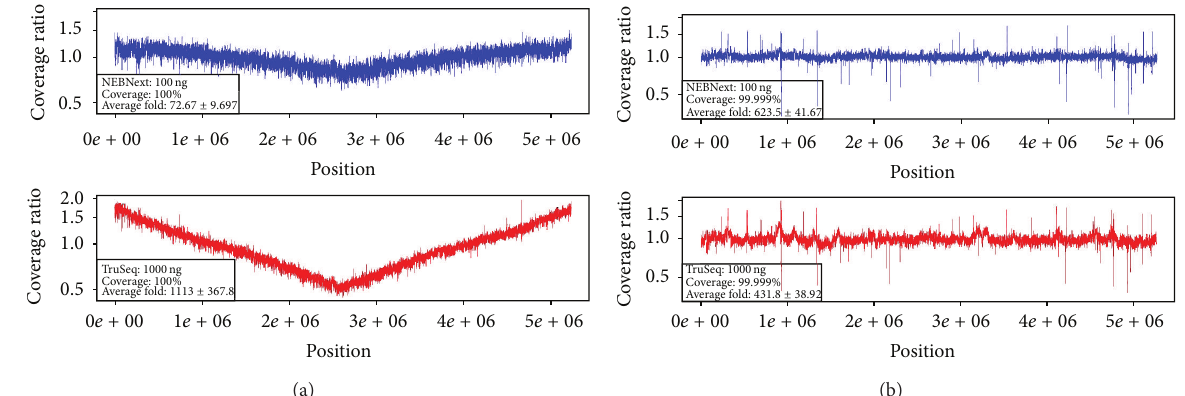
Figure 1: Evenness of coverage for B. anthracis (a) and E. coli (b) genome sequencing using NEBNext library preparation with 100ng DNA input (top graph) and TruSeq library preparation with 1,000 ng DNA input (bottom graph). Plots are normalized by the average coverage in each